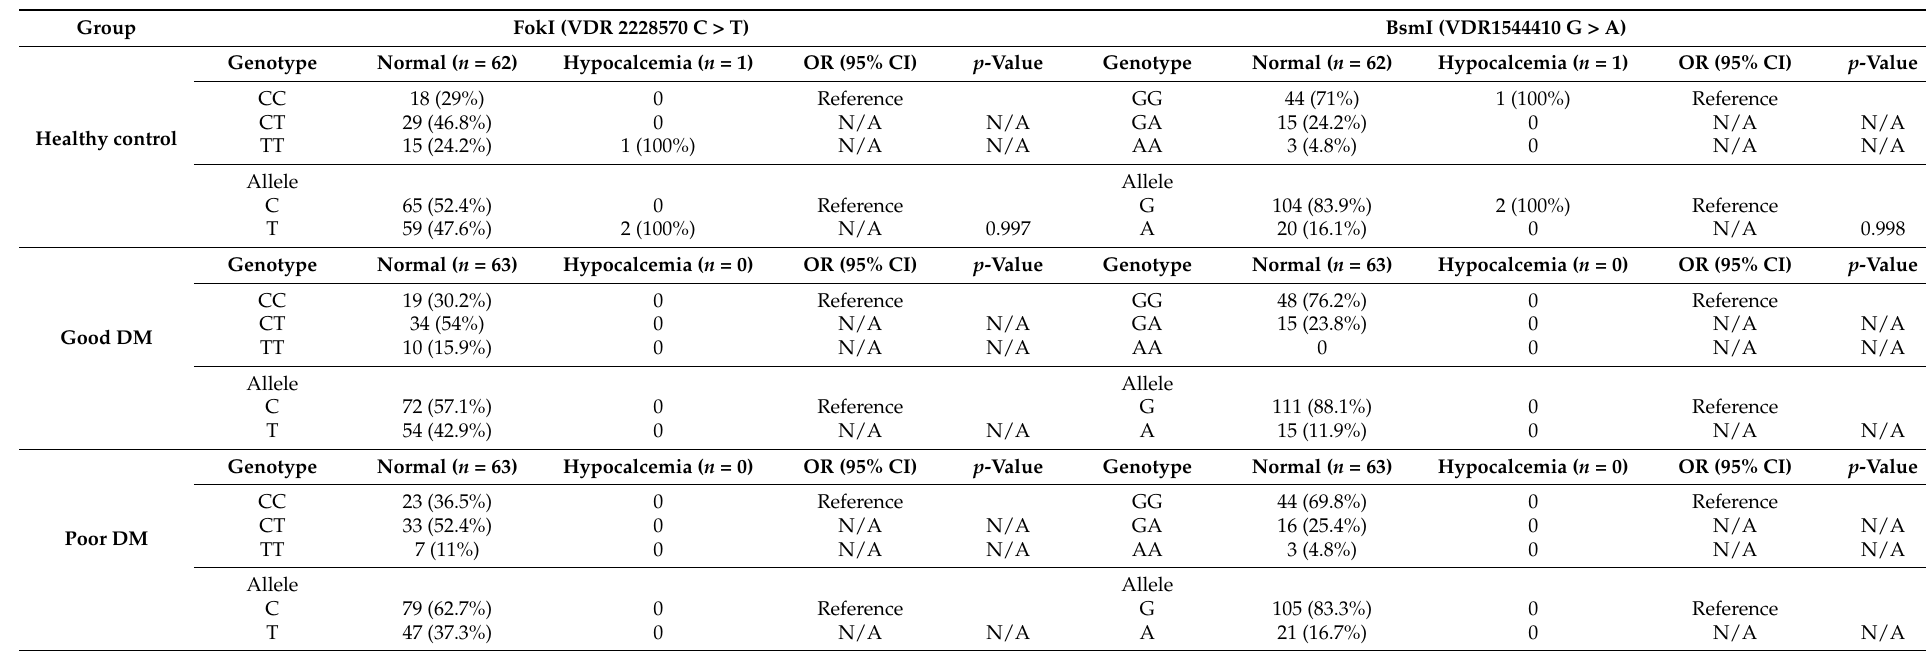
Table 7. Association between VDR polymorphism at FokI (VDR 2228570 C > T) and BsmI (VDR1544410 G > A) and risk of